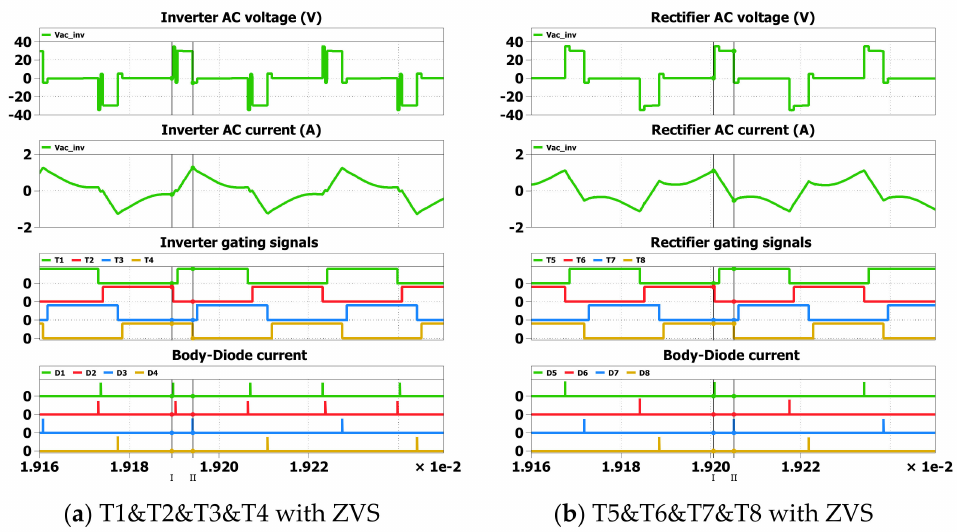
Figure 17. Inverter/rectifier voltage/current, MOSFET gating signals, diode currents PLECS circuit simulation results for Vo = 30 V, Io = 0.1 A (R dc = 300 Ω , emulate CV mode) with β p (deg) = 47.065 ◦ , β s (deg) = 46.47 ◦ , δ (deg) = 110 ◦